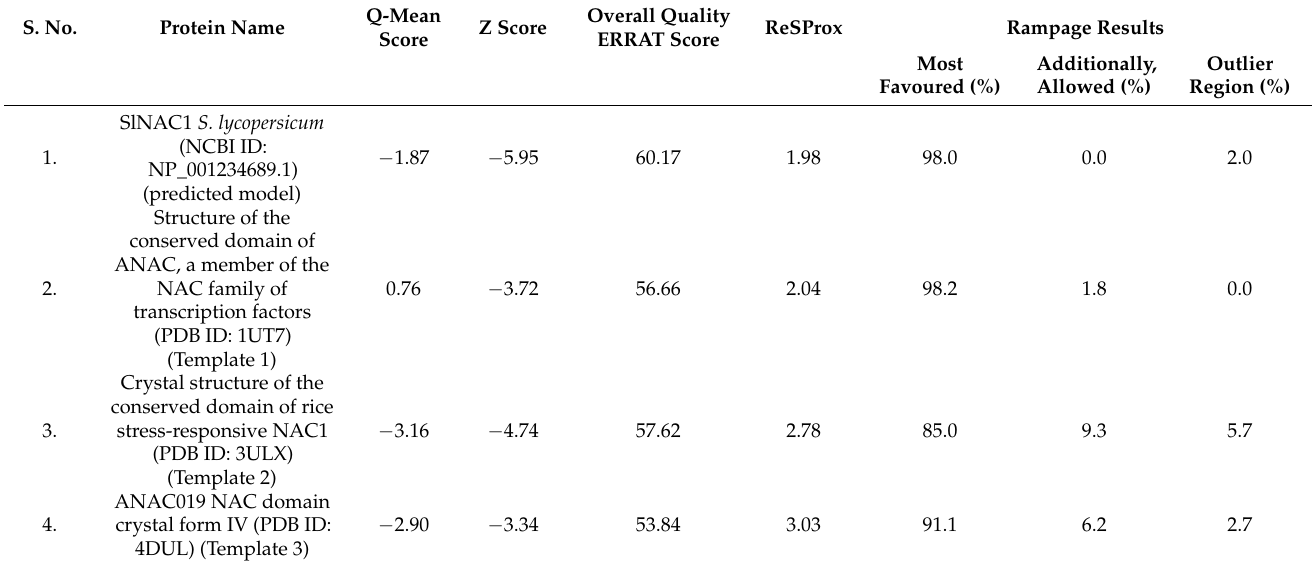
Table 2. Assessment of qualitative and quantitative scores for the modelled NAC1 protein and its comparison with the experimentally deduced (X-ray diffracted/NMR)